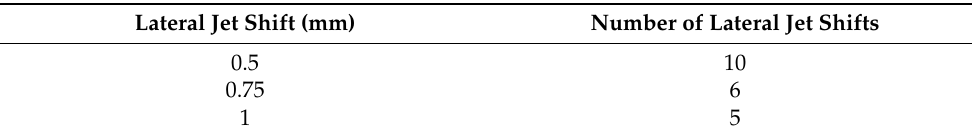
Table 7. Number of lateral jet